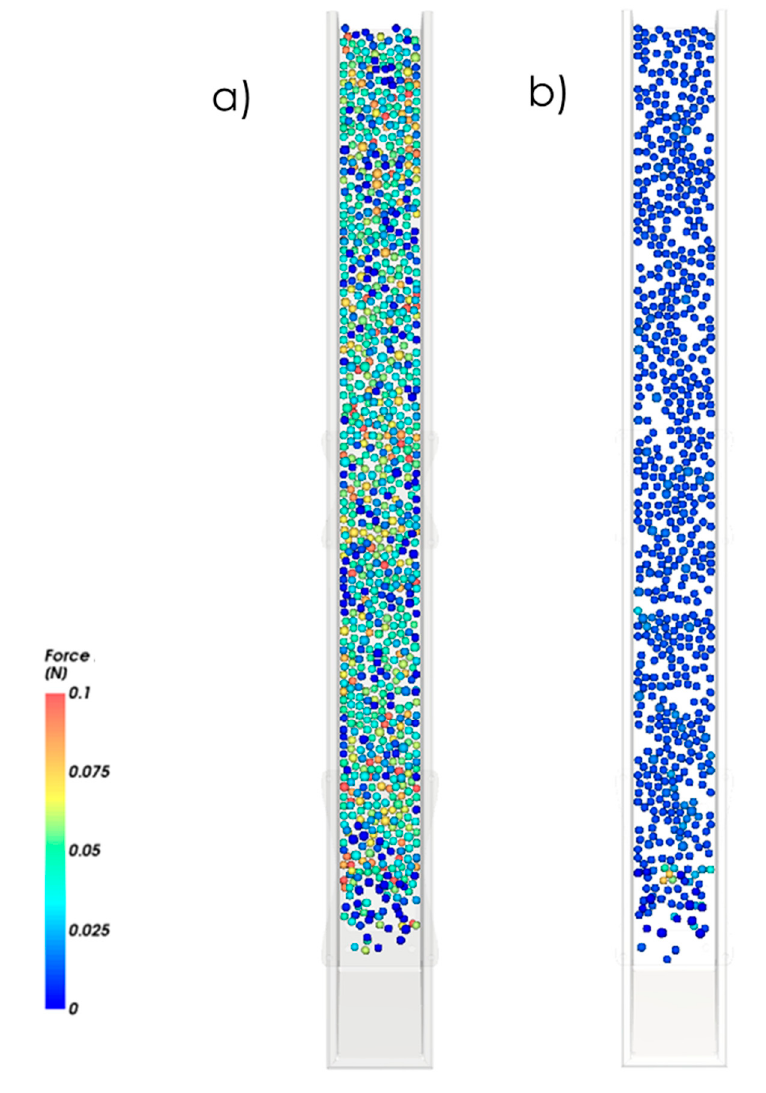
Figure 14. The comparison of normal force on blueberry fruit during transport on the reciprocating chute ( a ) and on the vibrating chute ( b ).